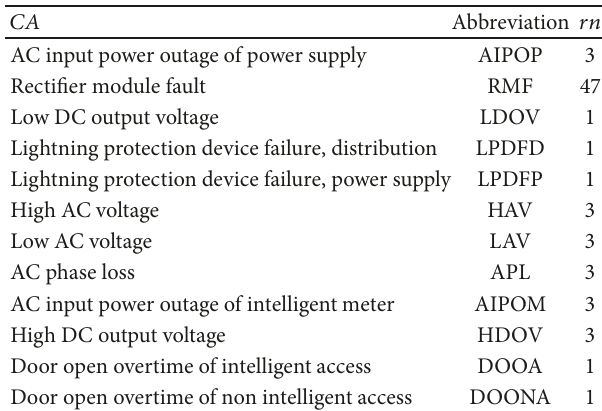
Table 3: System configuration.